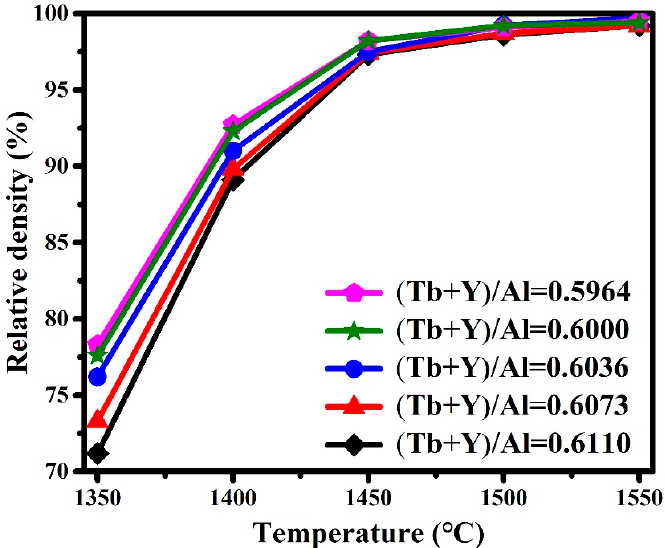
Figure 2. Relationship between relative density and pre-sintering temperature with different (Tb+Y)/Al ratios.